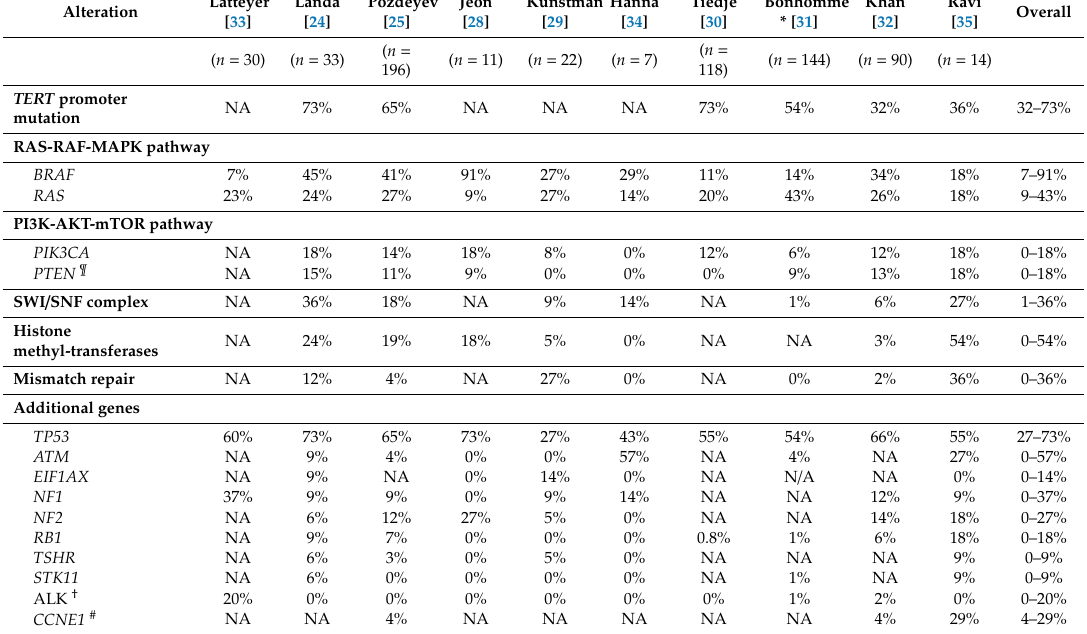
Table 1. Overview of the frequency of the most common alterations in ATC, based on next generation sequencing